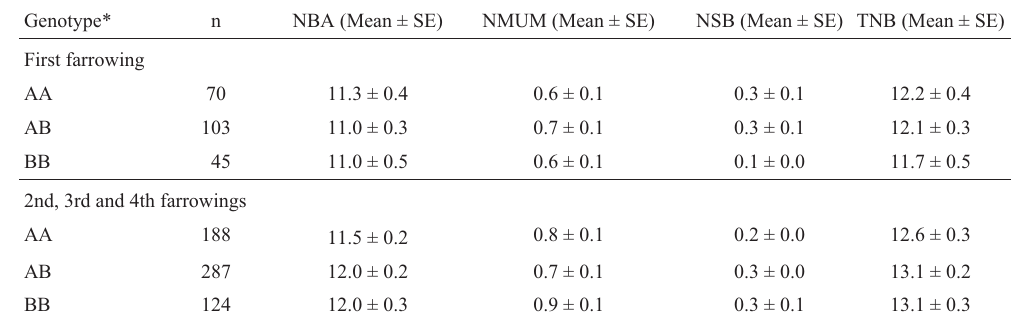
Table 2 - Association between estrogen receptor ( ER -PvuII) genotypes and mean number of piglets born alive (NBA), number of mummies (NMUM), number of stillborn piglets (NSB), and total number born (TNB) per litter at first parity and for all other parities.